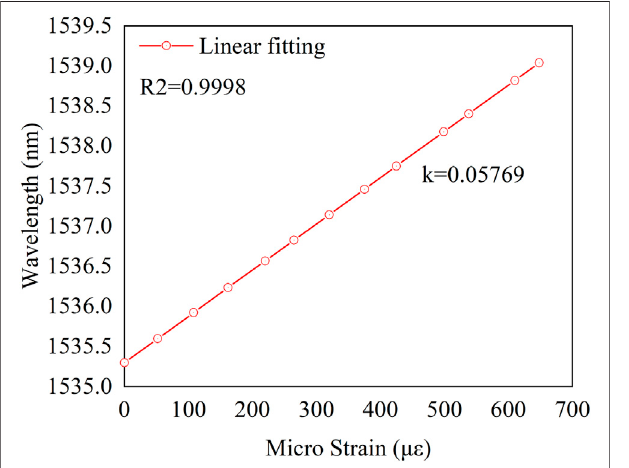
FIGURE 3 | Results of Fiber Bragg Grating (FBG) strain sensor calibration test.